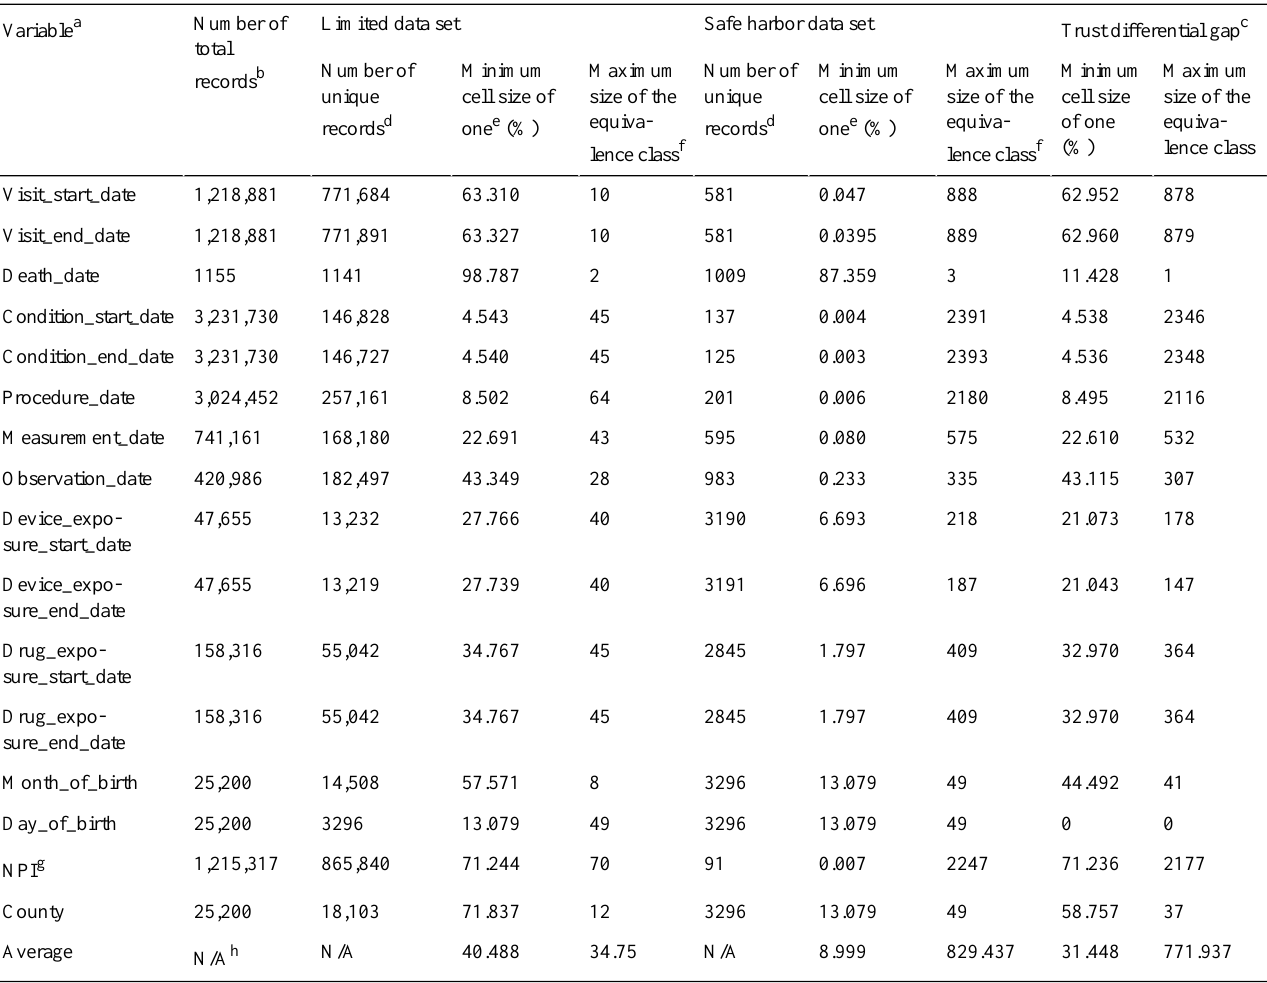
Table 3. Comparison of 16 personal health identifier variables and five demographic variables of the SynPUF5PCT with limited and safe harbor data sets in terms of a minimum cell size of one and the maximum size of the equivalence